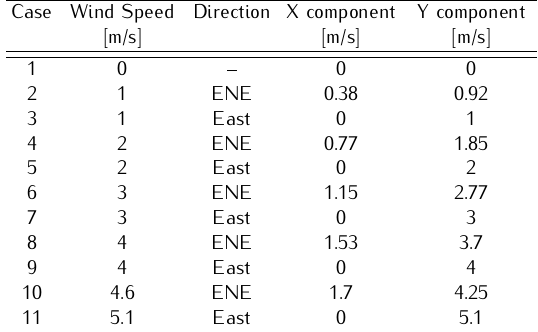
Table 4. Wind profile